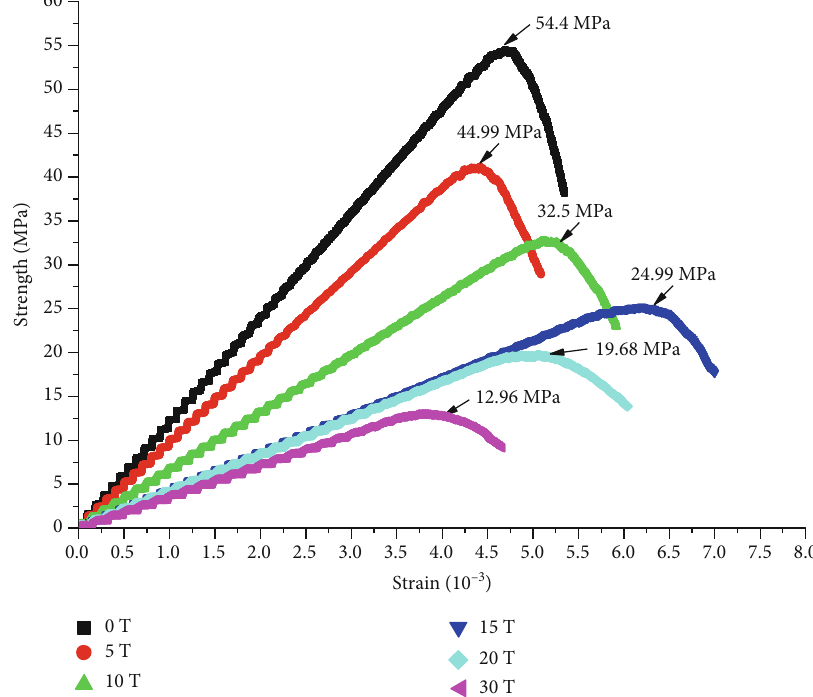
Figure 8: Numerical test results of mechanical strength attenuation under salt